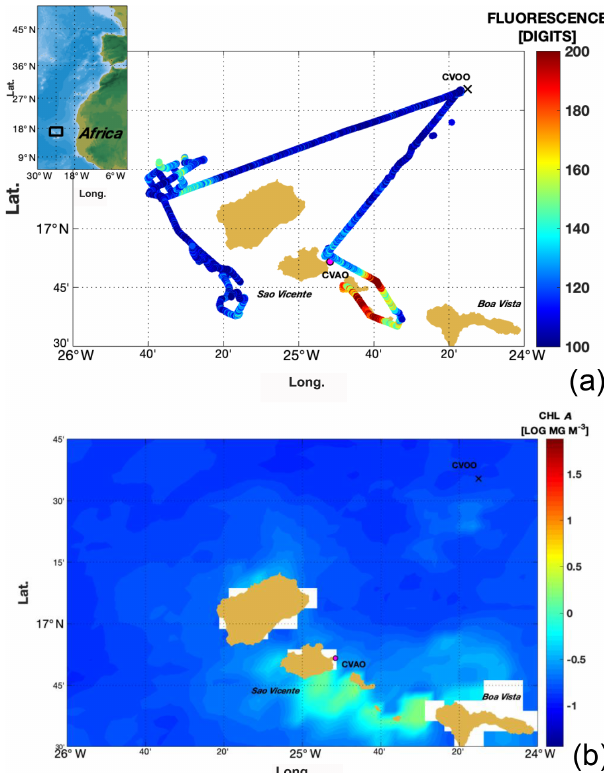
Figure 7. (a) The mission track of an SV2 wave glider as color- coded fluorescence data derived from a Wet LABS FLNTURT sen- sor installed on the vehicle (data in arbitrary units) (b) . Chloro- phyll a surface ocean concentrations derived from the MODIS Terra satellite (mean concentration for October 2017). Please note that logarithmic values are shown.